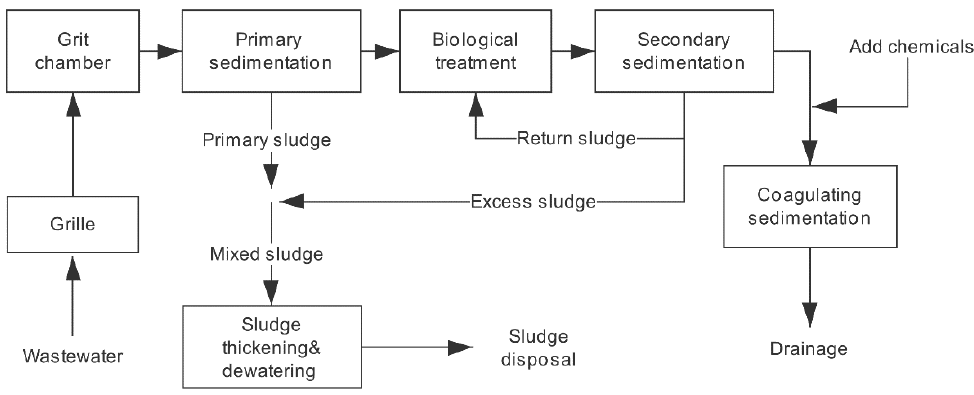
Figure 1. Flow chart of common wastewater and sludge (WW&S) treatments.